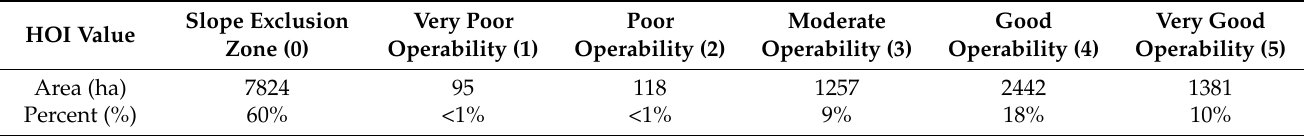
Figure 5. Output of the HOI model on a 1–5 tier scale of operability for Jocassee. Table 4. HOI values and corresponding land area for the 5-tier scale of operability in Jocassee. The total sampled area was 13,118 ha.